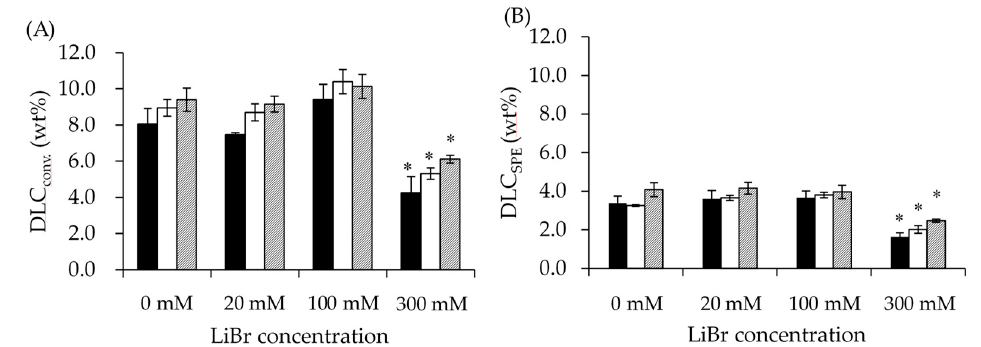
Figure 5. Drug loading contents (DLC) quantified by conventional method (DLC conv. , A ) and solid-phase extraction (DLC SPE , SPE) method ( B ). Filled bars, open bars, and hatched bars indicate flow rates of 8 mL/min, 3 mL/min, and 1 mL/min, respectively. Results are expressed as the mean ± standard deviation of three samples. The experiments were independently performed three times; * p < 0.05 to all other LiBr concentrations.